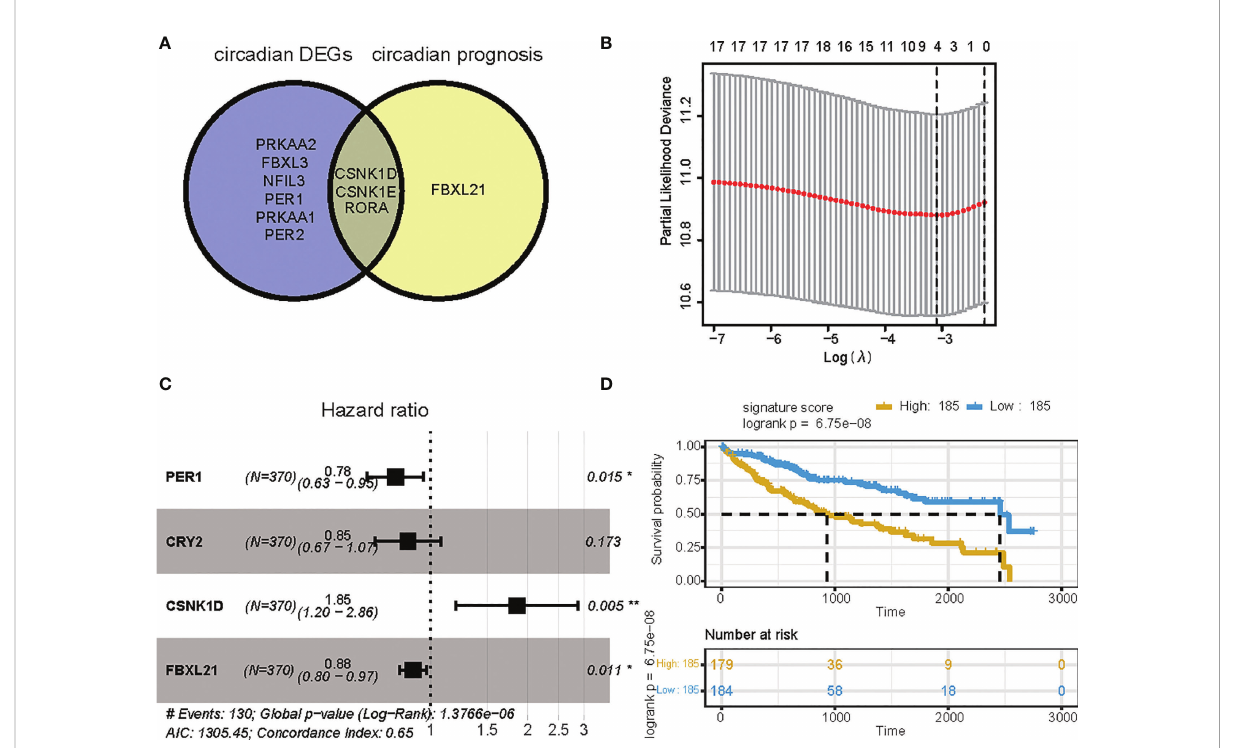
FIGURE 2 Survival analysis based on the risk score model. Survival analysis of the LIHC cohort in the TCGA. (A) Venn diagram of DEGs and prognostic genes that correlate with OS in tumor and tumor-adjacent normal tissue. (B) Lasso regression identi fi ed 4 genes correlated with prognosis. (C) Forest plots of the four genes that overlap between DEGs or prognostic genes that relate to OS based on univariate Cox regression analysis. (D) Kaplan Meier curves for the OS of patients in the high-risk and low-risk groups in the TCGA cohort (P-value <.0001). * p value < 0.05, ** p value <